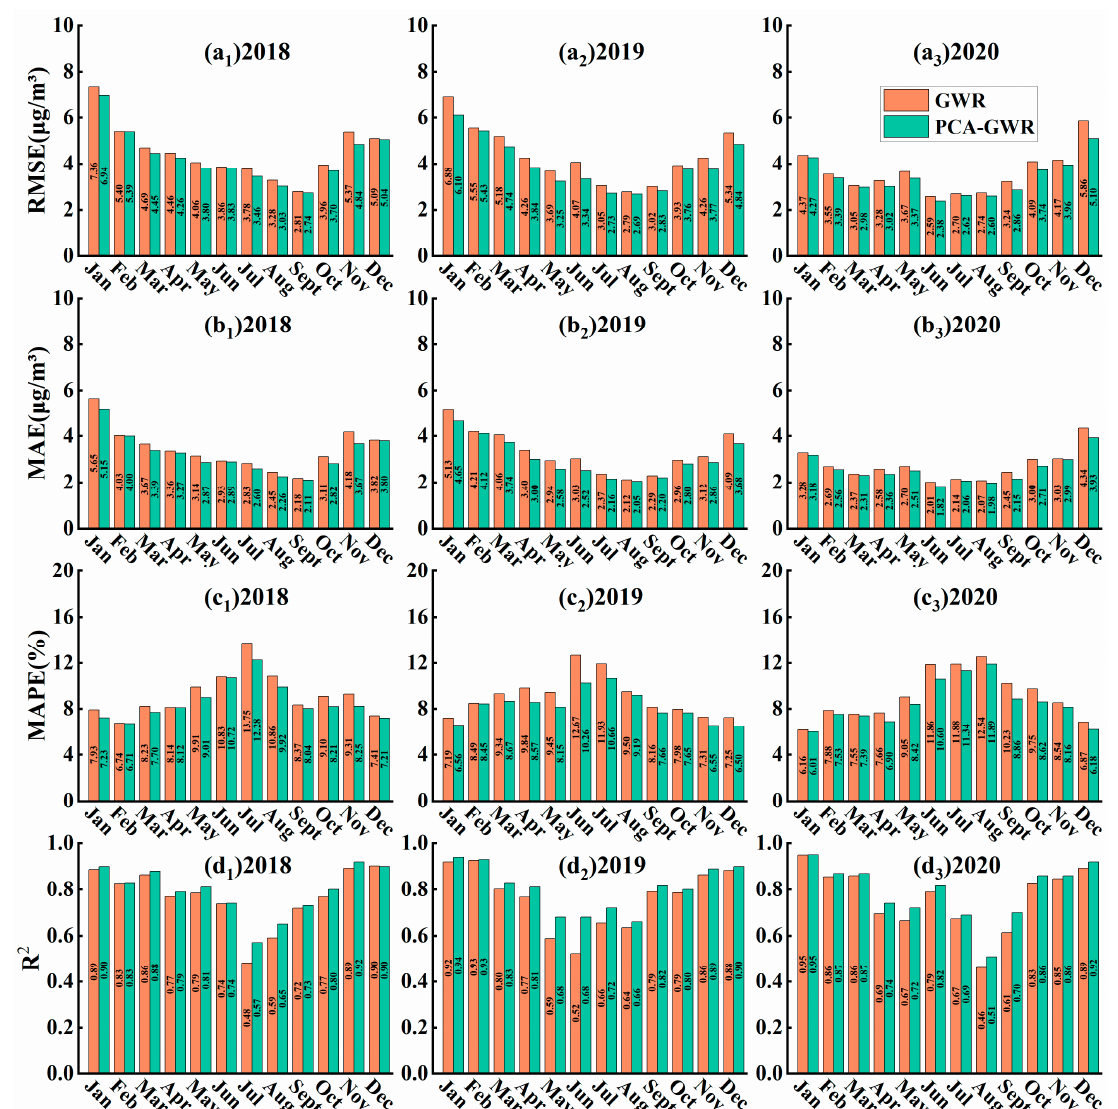
Figure 7. PCA-GWR and GWR model accuracy evaluation results, including RMSE for different months in ( a 1 ) 2018, ( a 2 ) 2019, ( a 3 ) 2020; MAE for different months in ( b 1 ) 2018, ( b 2 ) 2019, ( b 3 )